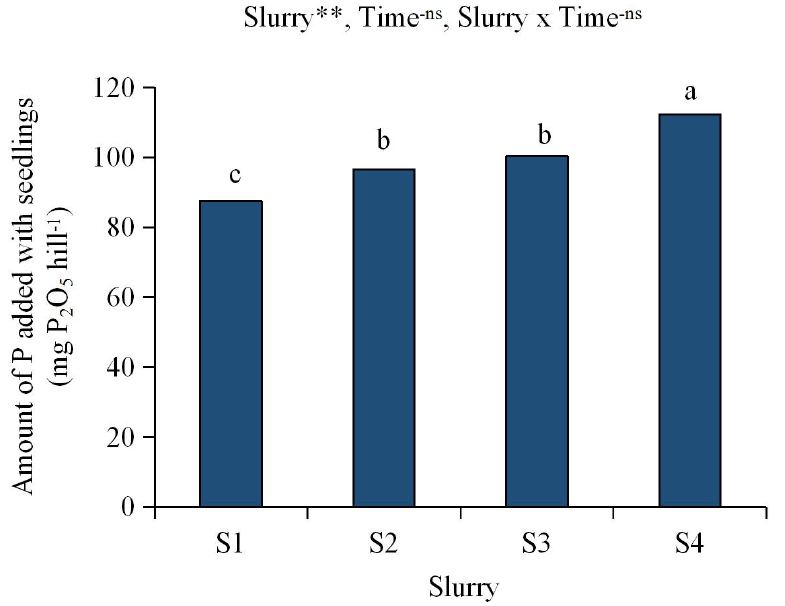
Figure 1. Effect of phosphorus concentration in slurry on the amount P added with seedlings at transplanting. ** p < 0.01, ns = not significant. The different letters within a column indicate significant differences between treatments at p < 0.05 using Tukey’s HSD test.